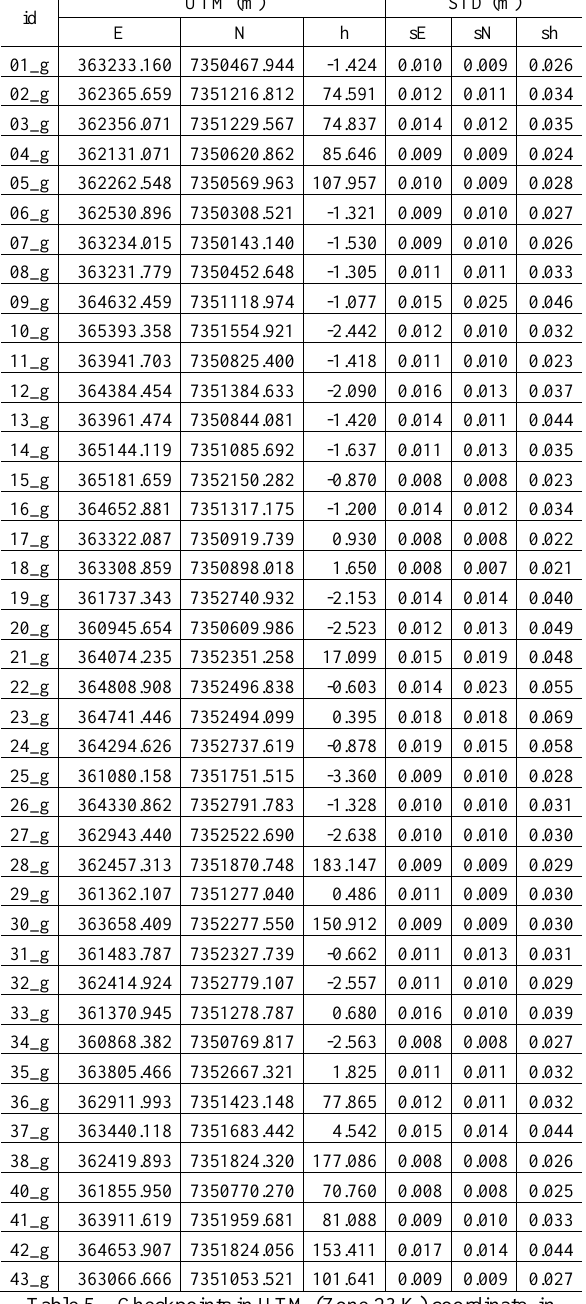
Table 5 – Checkpoints in UTM (Zone 23 K) coordinate, in meters.